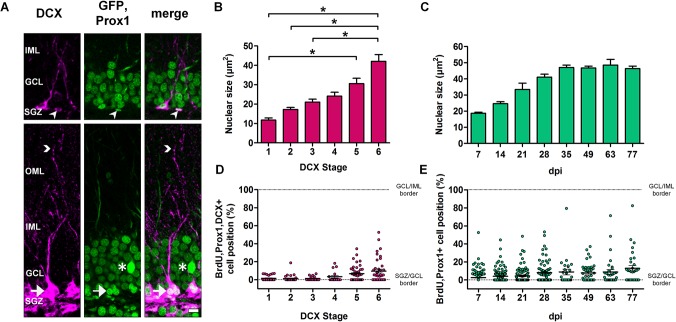
Nuclear size and soma position are positively correlated with structural maturation and age of newborn DGCs.(A) Examples of a 21-day-old stage 1 DCX/Prox1+ cell that is located in the subgranular zone (SGZ) and has no dendritic processes (arrowheads, upper panel) and a 21-day-old stage 6 DCX/Prox1+ cell (arrows, lower panel) with a dendrite extending into the outer molecular layer (OML; arrowheads, lower panel). Asterisk denotes the soma of an intensively labeled Thy1-GFP+ cell. (B) Nuclear size (determined with the nuclear marker Prox1, green) increased with structural maturity. There were significant differences in nuclear size between stages 1 and 6, as well as between stages 1 and 5, stages 2 and 6, and stages 3 and 6 (Kruskal-Wallis Dunn's multiple comparison test between animals, *P < 0.05; stage 1: n = 5 animals, stage 2: n = 7, stage 3: n = 4, stage 4: n = 6, stage 5: n = 9, stage 6: n = 11). (C) In BrdU/Prox1+ DGCs, nuclear size increased gradually with age until it reached a plateau at 35 dpi (n = 3 per group). (D, E) The majority of newborn DGCs was positioned in the SGZ and the inner half of the granule cell layer (GCL), regardless of structural stage and age. Error bars represent SEM. Scale bars in (A): 10μm. IML, inner molecular layer.